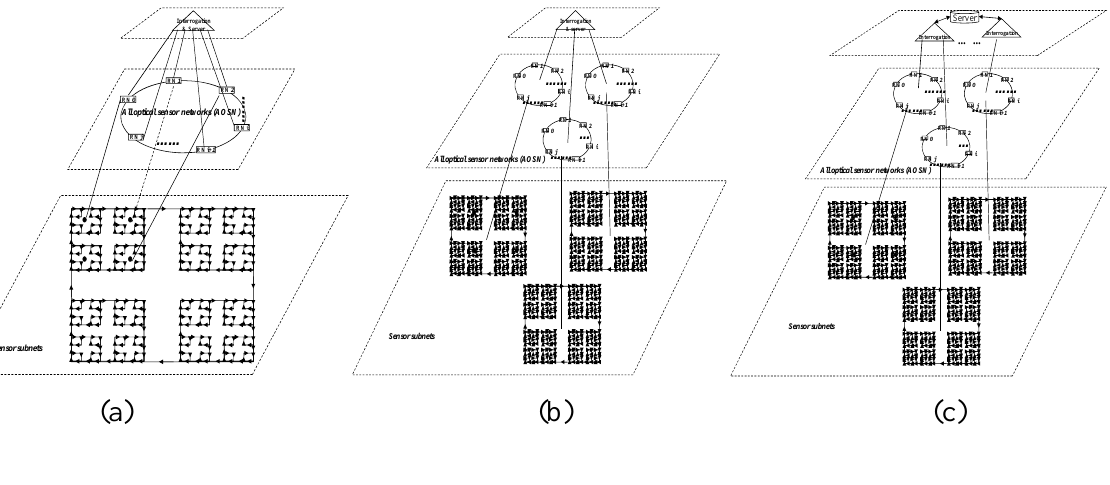
Figure 1. (a) No grouping in the first two levels; (b) Grouping in the second level; (c) Grouping in the first and second